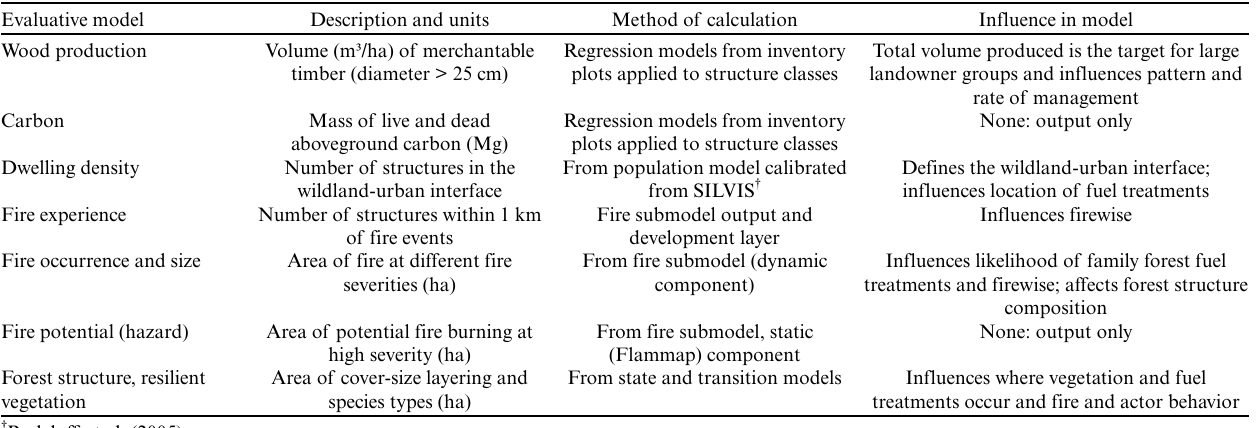
Table 1. Characteristics of evaluative metrics and potential influence on model